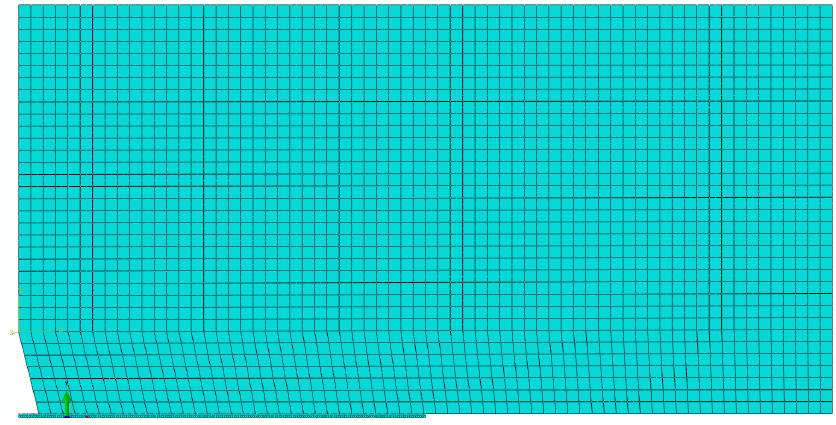
Figure 8. The finite element model for a strengthened concrete beam.